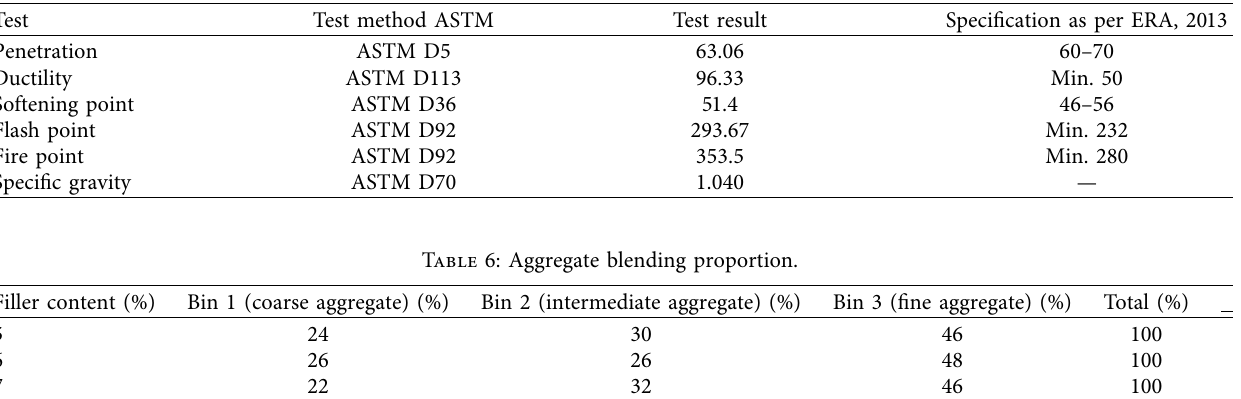
Figure 3: Particle size distribution of Belessa kaolin. Table 5: Asphalt binder quality test.